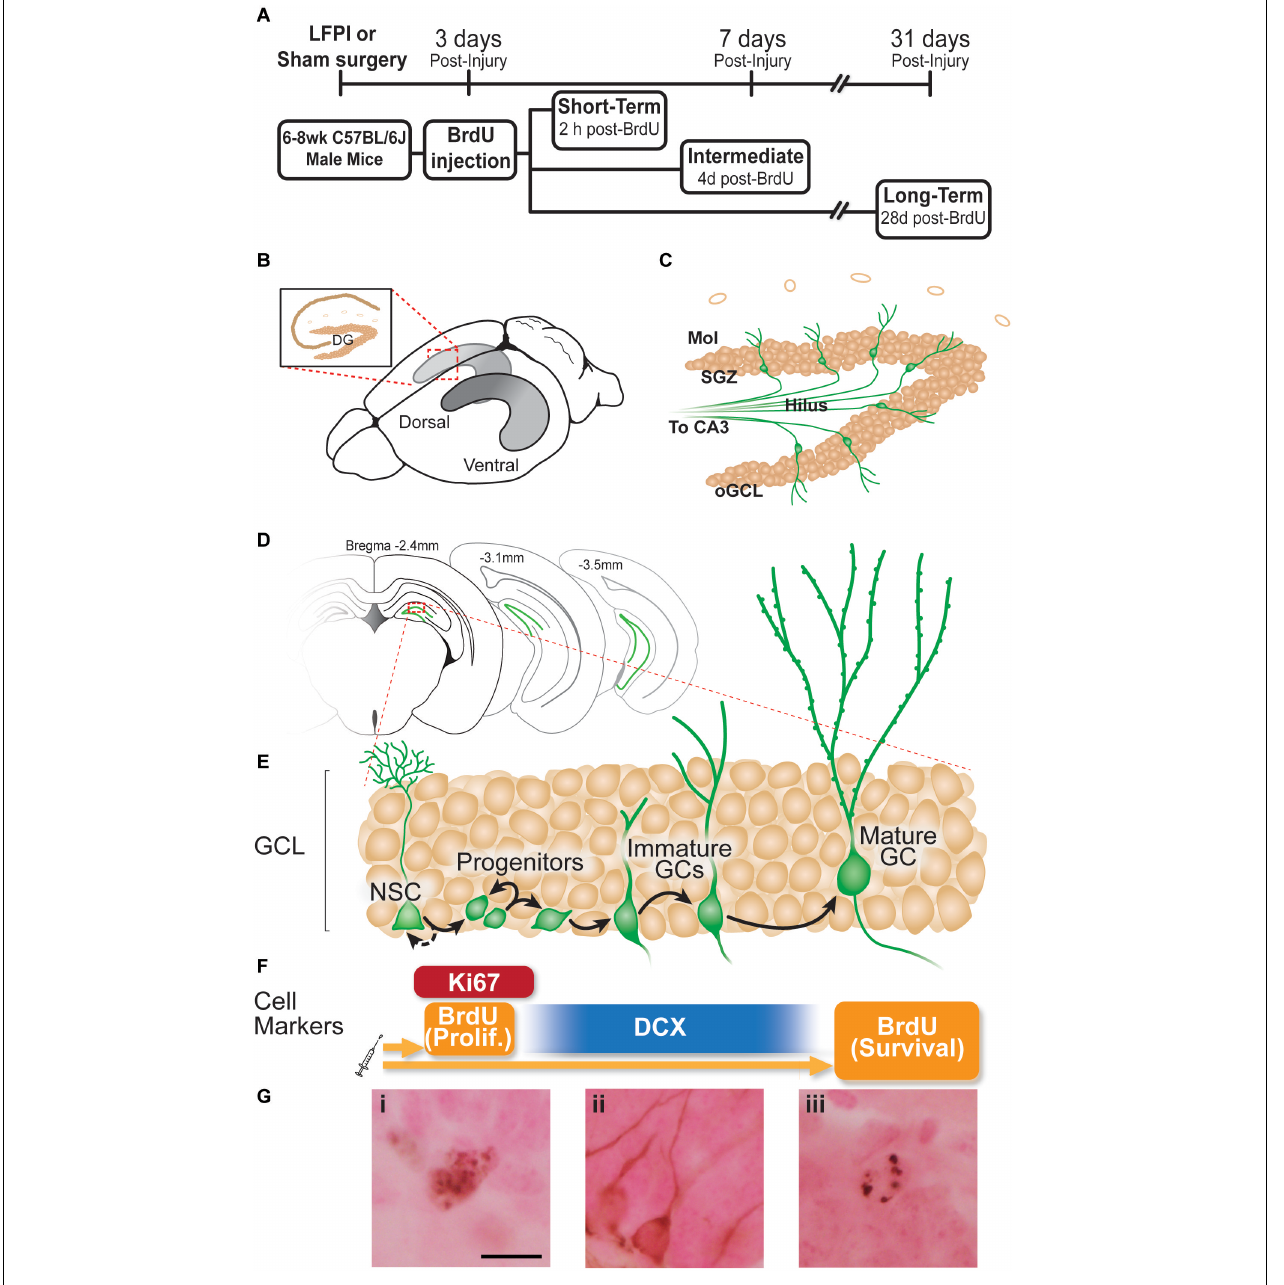
FIGURE 1 | Experimental timeline and overview of dentate gyrus (DG) neurogenesis and immunohistochemical markers used. (A) Timeline of experimental procedures. 6-8 week old male C57BL6/J mice received lateral fluid percussive injury (LFPI) or Sham surgery, and 150 mg/kg i.p. Bromodeoxyuridine (BrdU) injection 3 days post-injury (dpi). The Short-Term group was perfused 3 dpi (2 h post-BrdU); the Intermediate group perfused 7 dpi (4 days post-BrdU); and the Long-Term group perfused 31 dpi (28 days post-BrdU). (B) Schematic of a whole mouse brain showing bilateral location of the hippocampus (gray structure). Exploded inset (red dotted lines) depicts a coronal section through the dorsal hippocampus (tan indicates primary cell layers) with the granule cell layer (GCL) of the DG indicated. (C) Schematic of enlarged DG subregions. GCL is represented by densely packed tan circles; individual tan circles represent dorsal boundary of DG (hippocampal fissure). Green circles/lines are GCL GCs and their axons project through the Hilus to eventually reach CA3 (not pictured). Mol: molecular layer. SGZ: subgranular zone. oGCL: outer granule cell layer. (D) Schematic of location of DG (green lines) in coronal sections of a mouse brain at three distances from Bregma ( − 2.4, − 3.1, and 4-3.5 mm). (E,F) Exploded inset of red dotted line in (D) depicts stages of GCL neurogenesis and the antibodies with which cells in each neurogenesis stage can be labeled. Neural stem cells (NSCs) asymmetrically divide to create progenitor cells, whose progeny differentiate into immature granule cells, some of which survive to become mature granule cells. BrdU (in the Short-Term group) and Ki67 (all groups) mark dividing cells; doublecortin (DCX) marks neuroblasts/immature neurons (in all groups); and BrdU in the Long-term group marks surviving cells (cells that were dividing and labeled at the time of BrdU injection, and have survived to 31 dpi). (G) Representative photomicrographs of cells stained with antibodies against Ki67 (Gi), DCX (Gii), or BrdU (Giii). Scale bar = 10